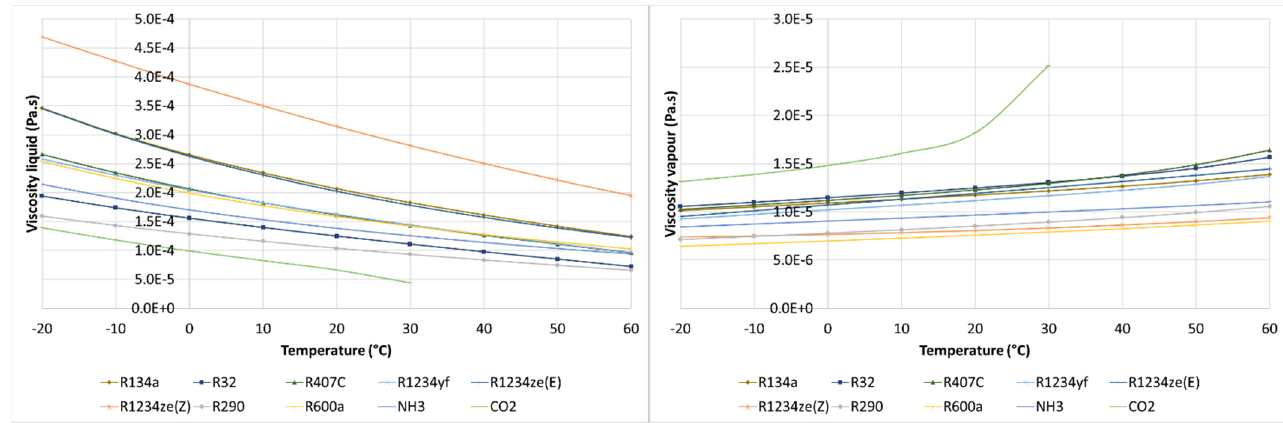
Figure 11. Comparison of evolutions of viscosity depending on temperature.